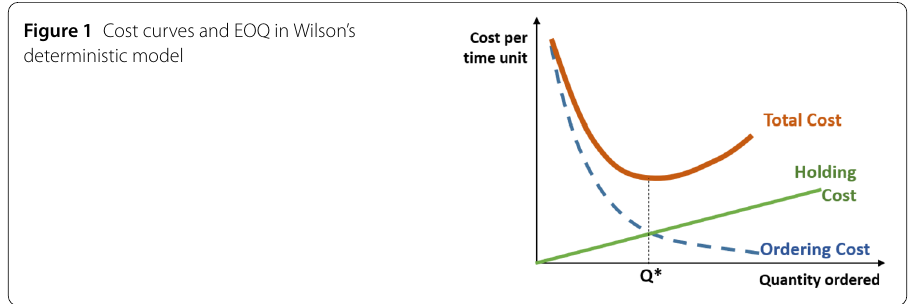
Figure 1 Cost curves and EOQ in Wilson’s deterministic